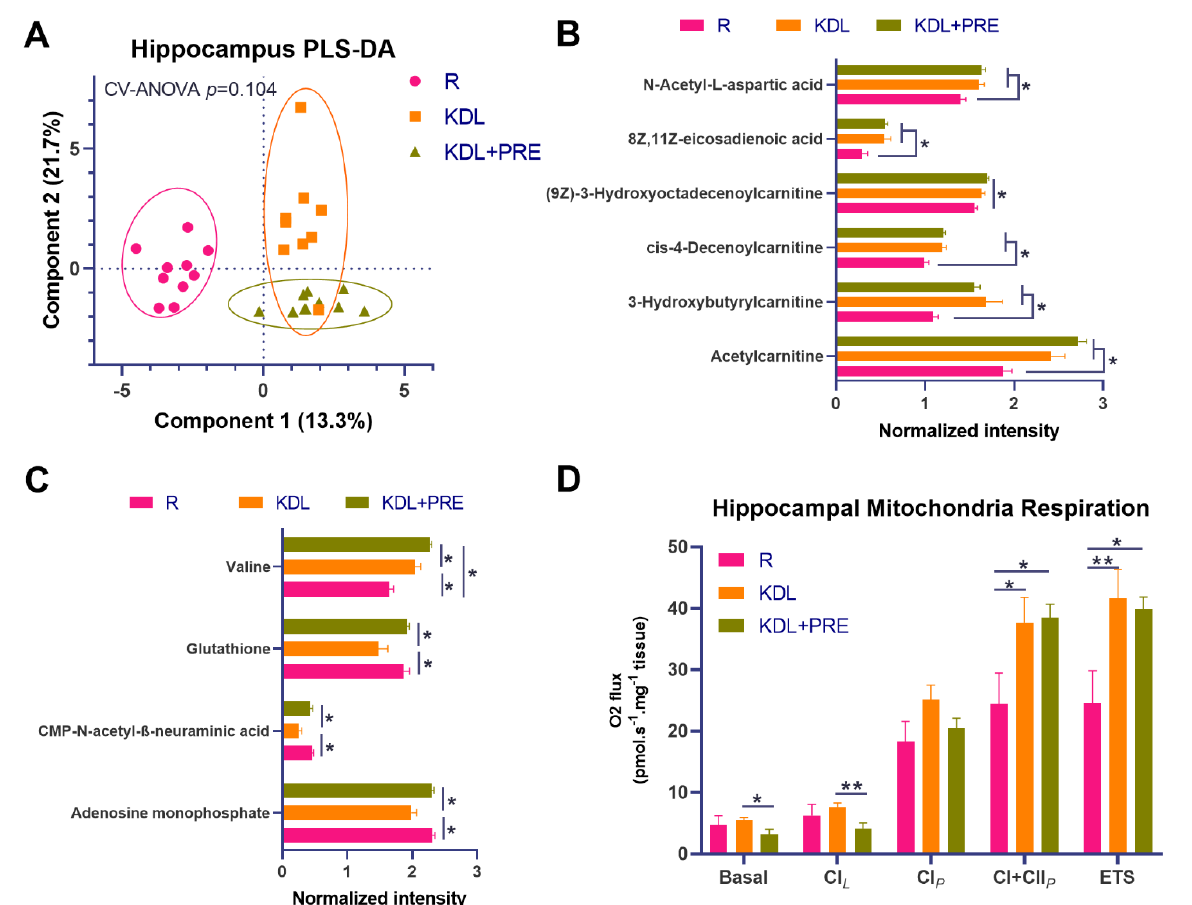
Figure 4. Effects of prebiotic inclusion on the metabolic phenotype and mitochondrial respiration in the hippocampus. ( A ) PLS-DA analysis of hippocampal metabolites. ( B ) Metabolites with significant changes in both KDL and KDL+PRE groups relative to R control group. ( C ) Metabolites with significant changes in KDL+PRE group against KDL group. ( D ) Mitochondrial respiratory measurements as follows; Basal, basal respiration; CI L , non-phosphorylating LEAK respiration; CI P , OXPHOS capacity of CI-linked activity; CI+CII P , OXPHOS capacity with combined CI and II-linked substrates; ETS, maximum capacity of the electron transfer system. R-normally developing reference group; KDL-ketogenic diet formula; KDL+PRE-ketogenic diet formula plus prebiotic fiber. Data are presented as mean ± SEM. n = 9–11 rats/group. * p < 0.05, ** p < 0.01.